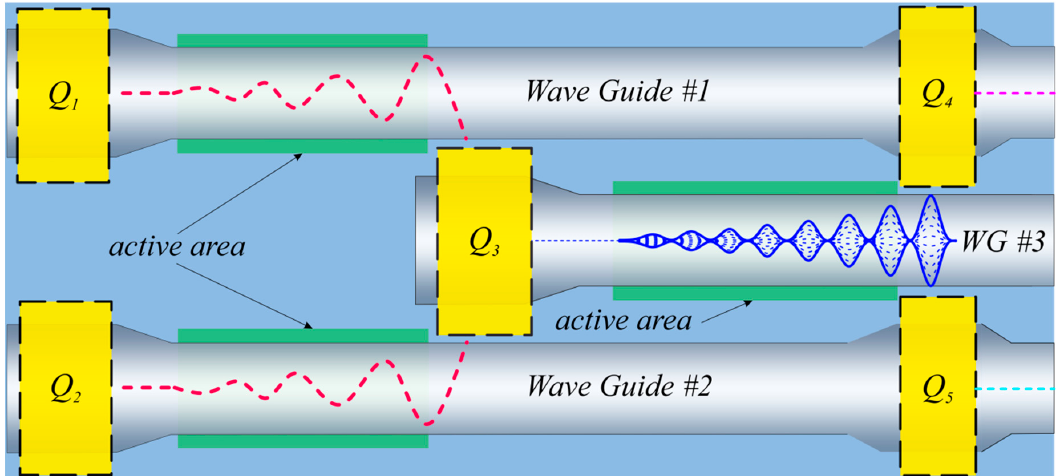
Figure 8. General scheme (top view) of the signal transfer and control through the waveguide between qubits. Q 1 , Q 2 , Q 3 , Q 4 , Q 5 are the elements of the hybrid computing circuit, which are connected with the considered waveguide structures with parabolic spatial dependence of susceptibility. The susceptibility modulations in the “active areas” are governed by the applied DC voltage, which can control the local density of the dopants. As a result, the beam can be forwarded from a given ‘’source” to a given “receiver” in order to perform a specific operation.